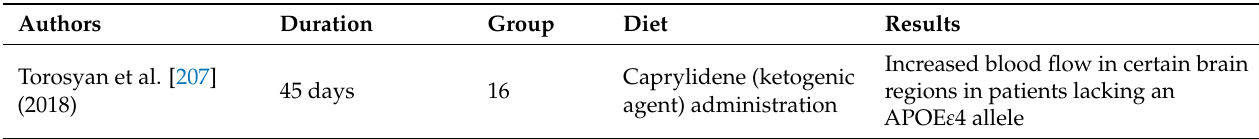
Table 3. Results of clinical trials and randomised controlled trials conducted on patients with Alzheimer’s disease over the past 7 years to determine the therapeutic efficacy of nutritional